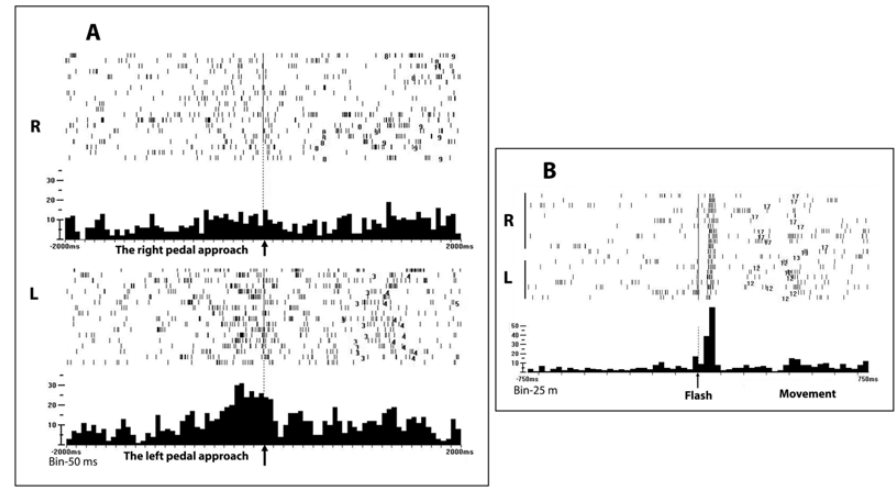
Figure 2. Activity of a representative task-related neuron specialized in relation to the left pedal approach during the instrumental behavior on both sides (A) and during the delay period